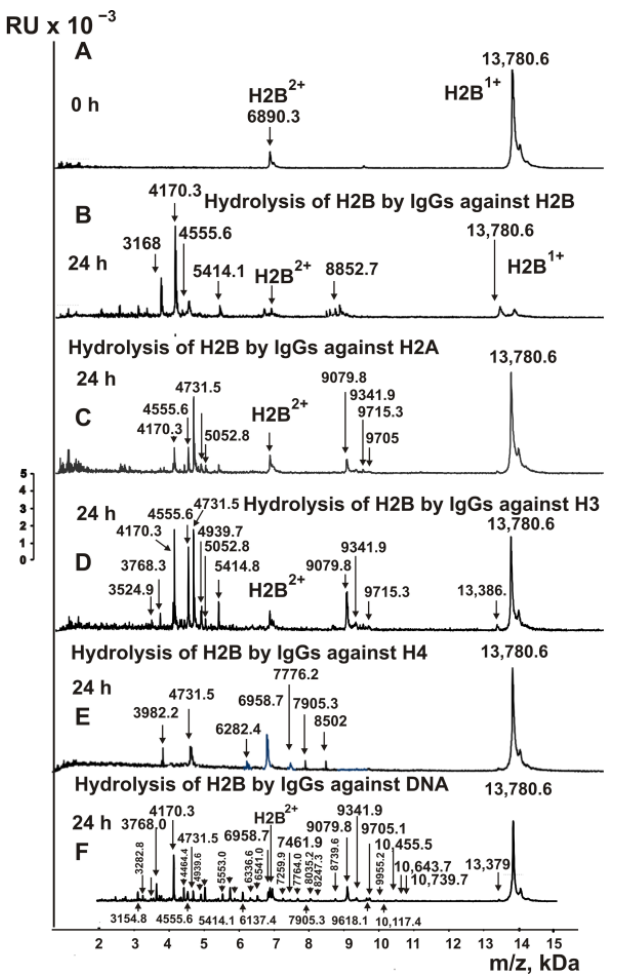
Figure 5. MALDI spectra show H2B histone (0.8 mg/mL) over time hydrolysis (0–24 h) in the presence of IgGs (0.045 mg/mL) against H2B, H2A, H3, H4 and DNA ( A – F ). All used IgG preparations and m/z of hydrolysis products (Da) are indicated on the